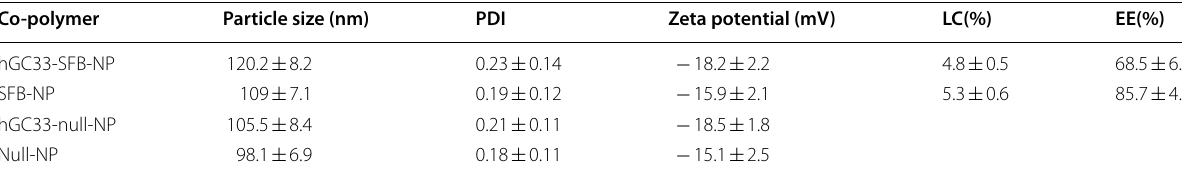
Table 1 Physical and chemical characteristics of NPs